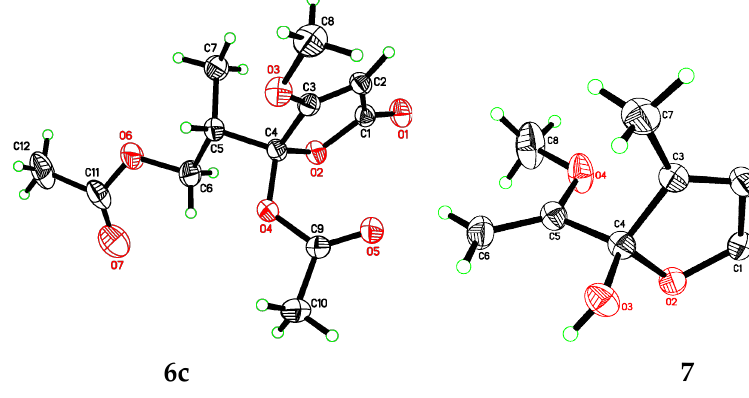
Figure 4. Tautomeric forms ( γ -keto-acids and γ -hydroxyl butenolides) of 6 , and the reaction of 6 Figure 5. X-ray ORTEP diagrams of 6c and 7 . with AcCl.